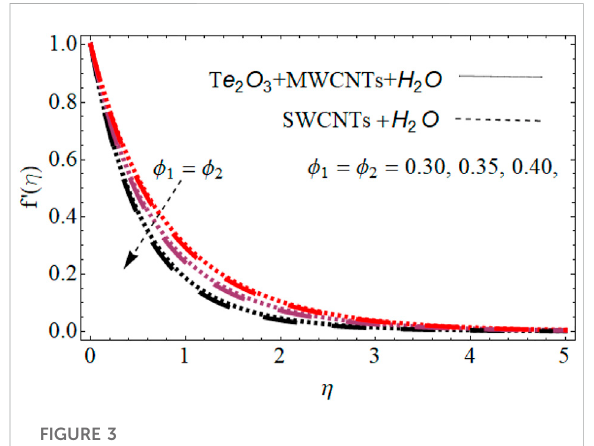
FIGURE 5 Inspiration of the solar radiation parameter on the velocity pro fi le.